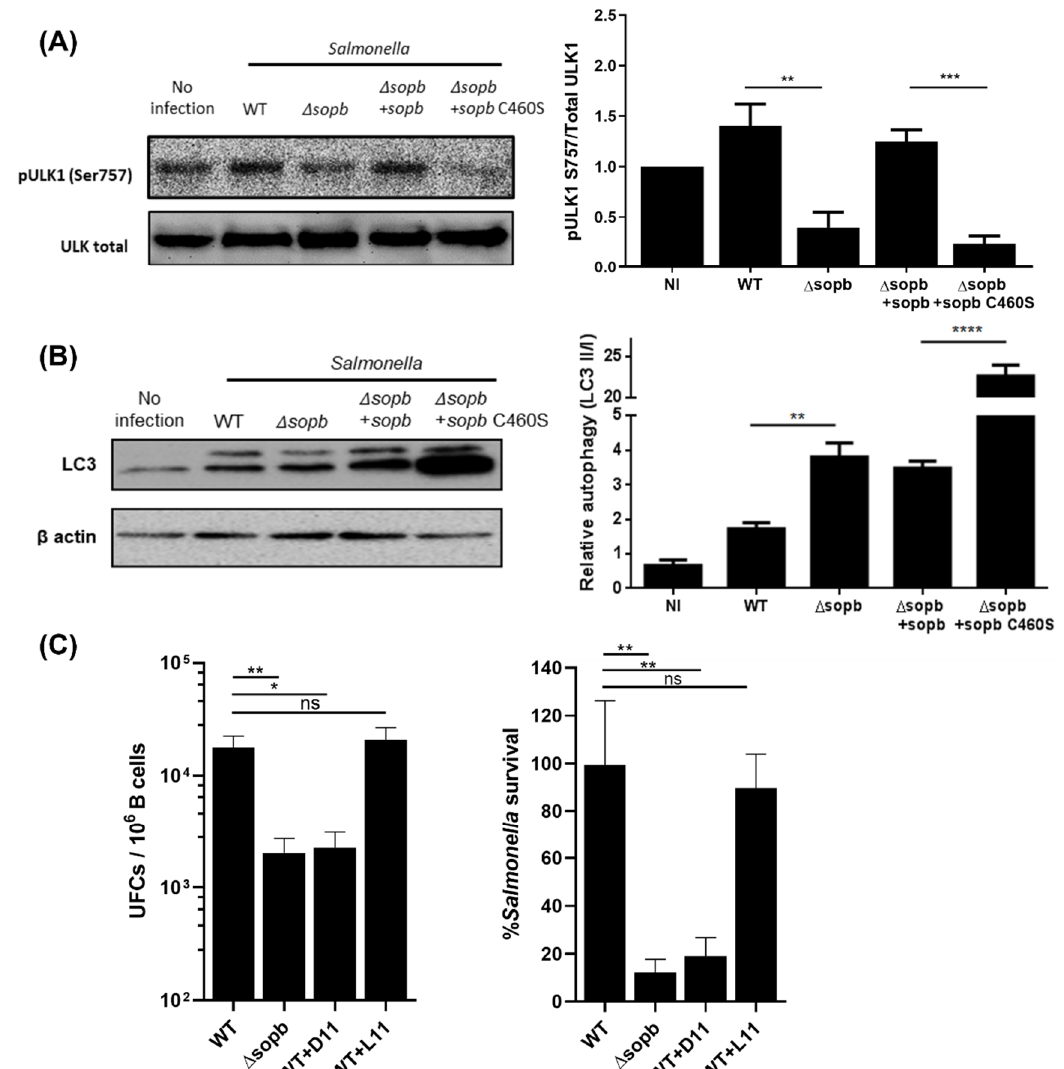
Figure 3. SopB-mediated activation of mTORC1 inhibits autophagy. Detection of pULK1 (S757) ( A ) or LC3-I/LC3-II ( B ) in B cells infected with indicated Salmonella strains for 3 h. ( C ) CFUs recovered from B cells infected with Salmonella strains for 24 h and treated for 1.5 h with autophagy-inducer peptide D11(20 µ M) or scramble peptide L11 (20 µ M). The percentage of Salmonella survival in ( C ) was calculated by considering Salmonella WT as 100% of survival. Results are expressed as means ± SDs. n = 3. An unpaired Student’s t -test was used for the bars. * p < 0.05, ** p < 0.01, *** p < 0.001, and **** p < 0.0001 .